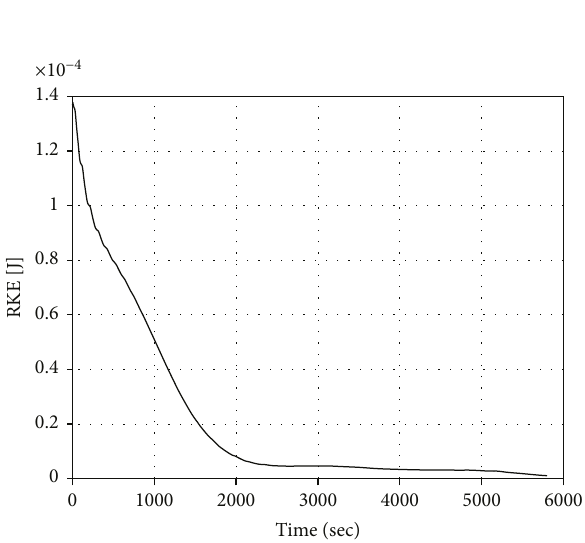
Figure 1: Rotational kinetic energy behavior during Tigrisat detumbling.